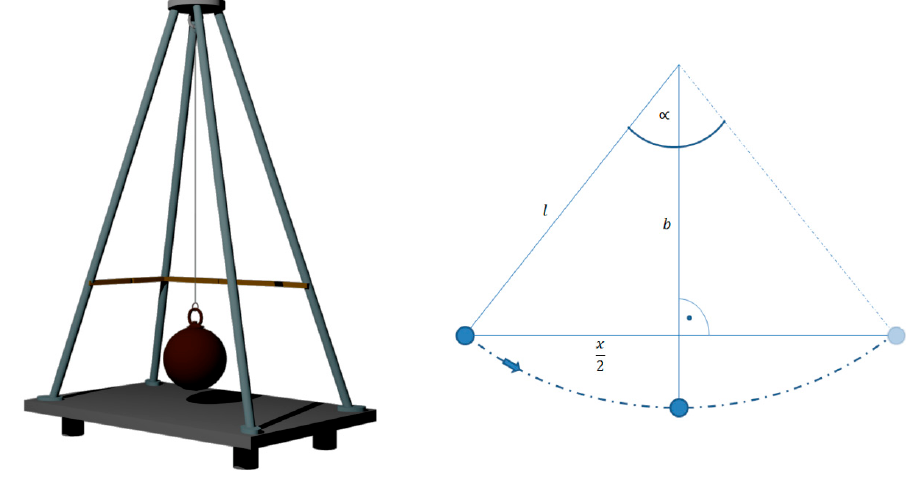
Figure 1. left : pendulum with attached weight, mounted on a Kistler force plate [18]; right : Mathematical model of the pendulum stand for the quantification of the pendulum swings with the length of the pendulum l, the angle of release α and the projected path x.